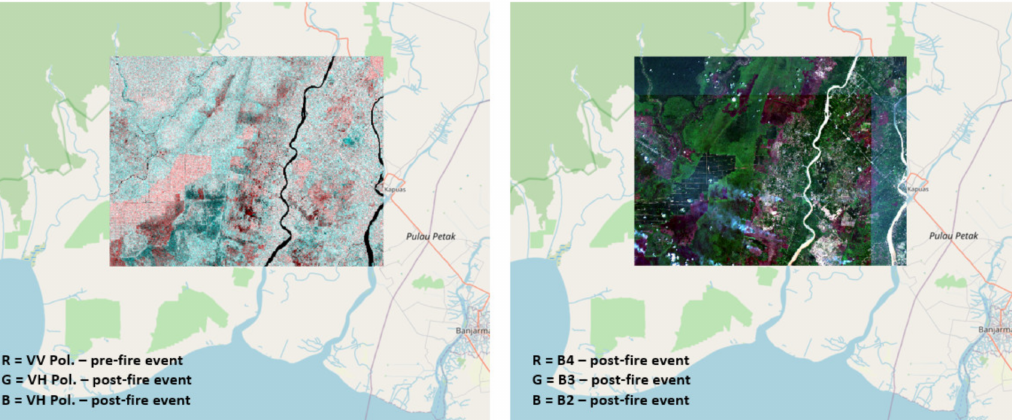
Figure 2. Mosaic Sentinel-1 SAR images (left) and Sentinel-2 optical images (right) used in the area of interest.